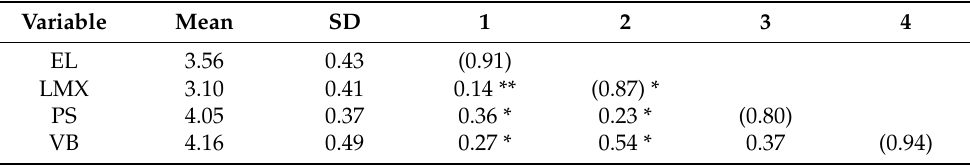
Table 2. Means, standard deviations, correlations, and composite reliability.